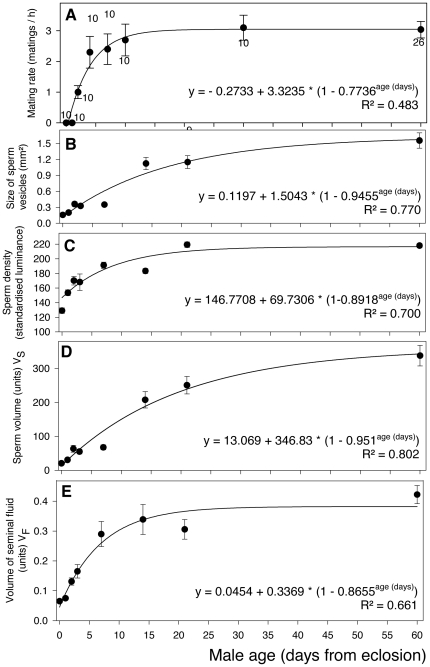
Age-related reproductive parameters of the common bedbug Cimex lectularius.Mating rate (a), size of sperm vesicles (b), sperm density (c), and the volume of sperm (VS) (d) and seminal fluid (VF) (e) increases with male age in the common bedbug. VS (d) is a composite measure of sperm vesicle size and sperm density. Circles represent means, error bars = 1 standard error. Sample sizes are given near the mean values for each age group. Samples sizes in c–e are identical. Equations in graphs represent regression parameters from curve fitting procedures.